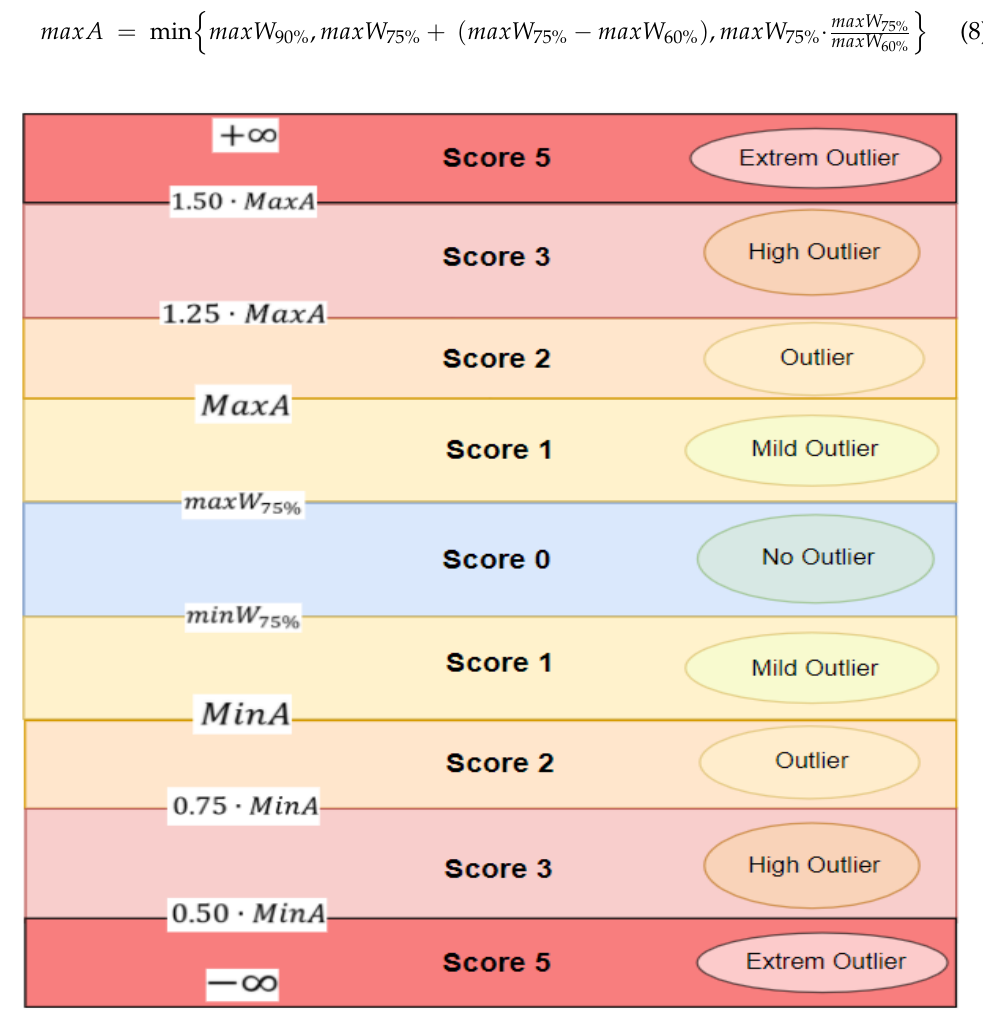
Figure 4. Outlier scoring range over cluster A.